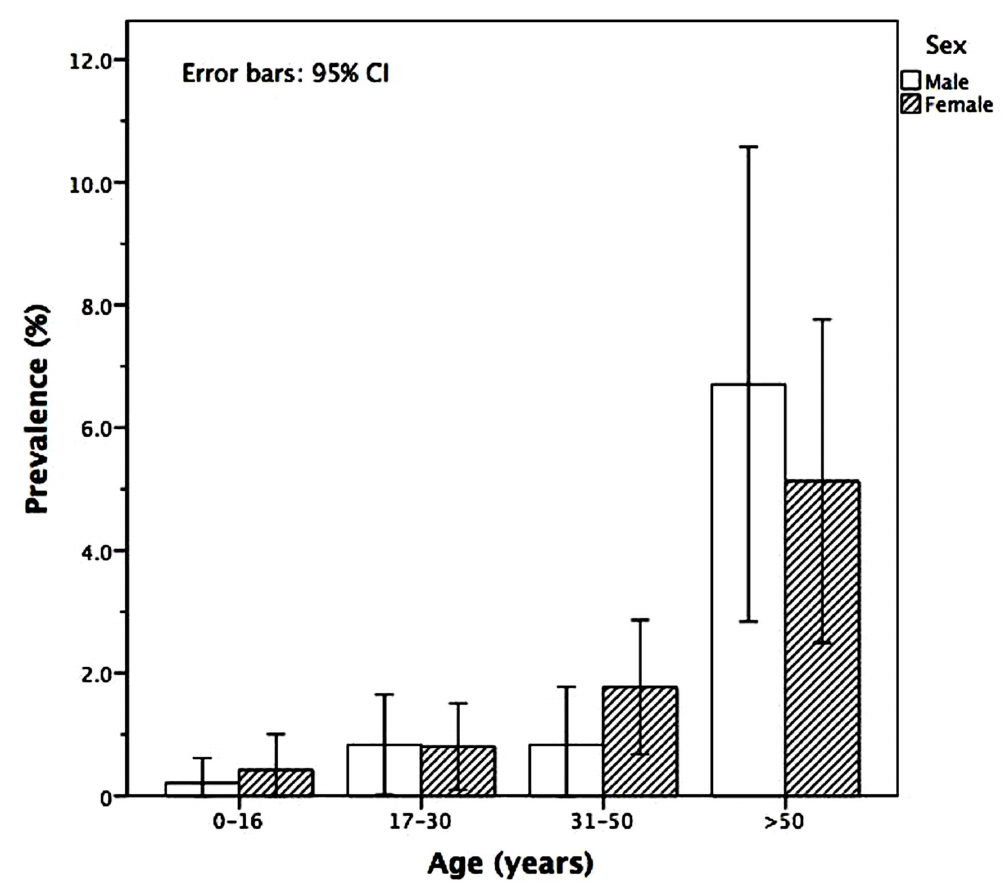
Fig 1. Prevalence of HTLV-1 infection among males and females in Salvador, Bahia-Brazil, stratified by age in years.